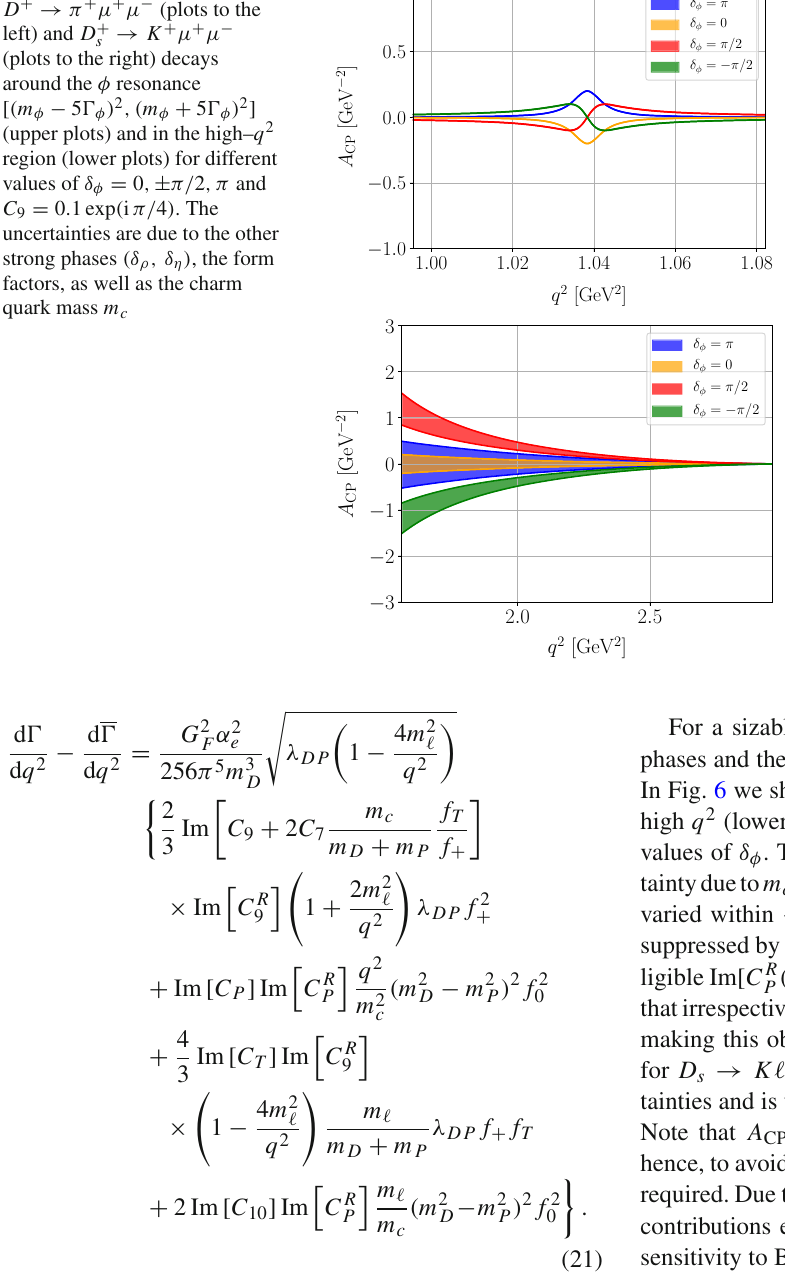
Fig. 6 The CP–asymmetry in D + → π + μ + μ − (plots to the left) and D + s → K + μ + μ − (plots to the right) decays around the φ resonance [ ( m φ − 5 (cid:11) φ ) 2 ,( m φ + 5 (cid:11) φ ) 2 ] (upper plots) and in the high– q 2 region (lower plots) for different values of δ φ = 0 , ± π/ 2 ,π and C 9 = 0 . 1exp ( i π/ 4 ) .